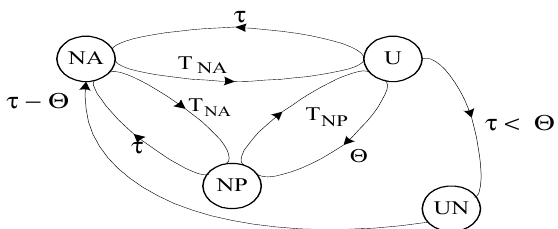
Figure 3. Graph of a model of an operation process of wind power plant with a maintenance system that is classically organized without any examination of the state in the assessment